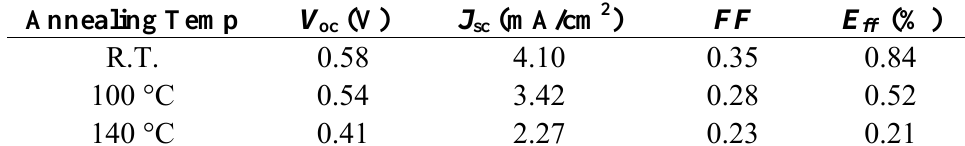
Table 4. The characteristics of polymer solar cells with P(3HT- b -3SFT). Annealing Temp